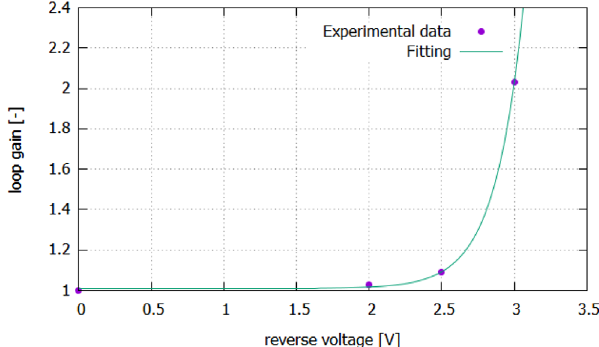
Fig. 3. Loop-gain as a function of reverse voltage. Loop-gain is increasing exponentially w.r.t the applied reverse biased